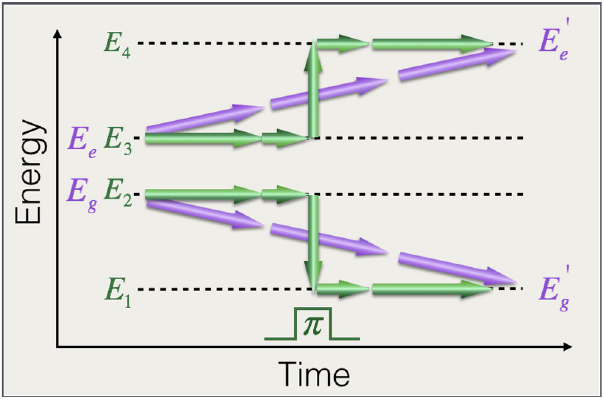
FIG. 2. In the standard two-level Otto engine, there are two- level E (purple arrows) that change in time to E 0 g;e multilevel embedding framework, the levels ( E 1 – 4 ) are fixed in time (black dashed lines), but a time-dependent field ( π pulse, swap operation) transfers the population (green arrows) to the other levels. For a swap operation, the two schemes lead to the same final state and therefore are associate with the same